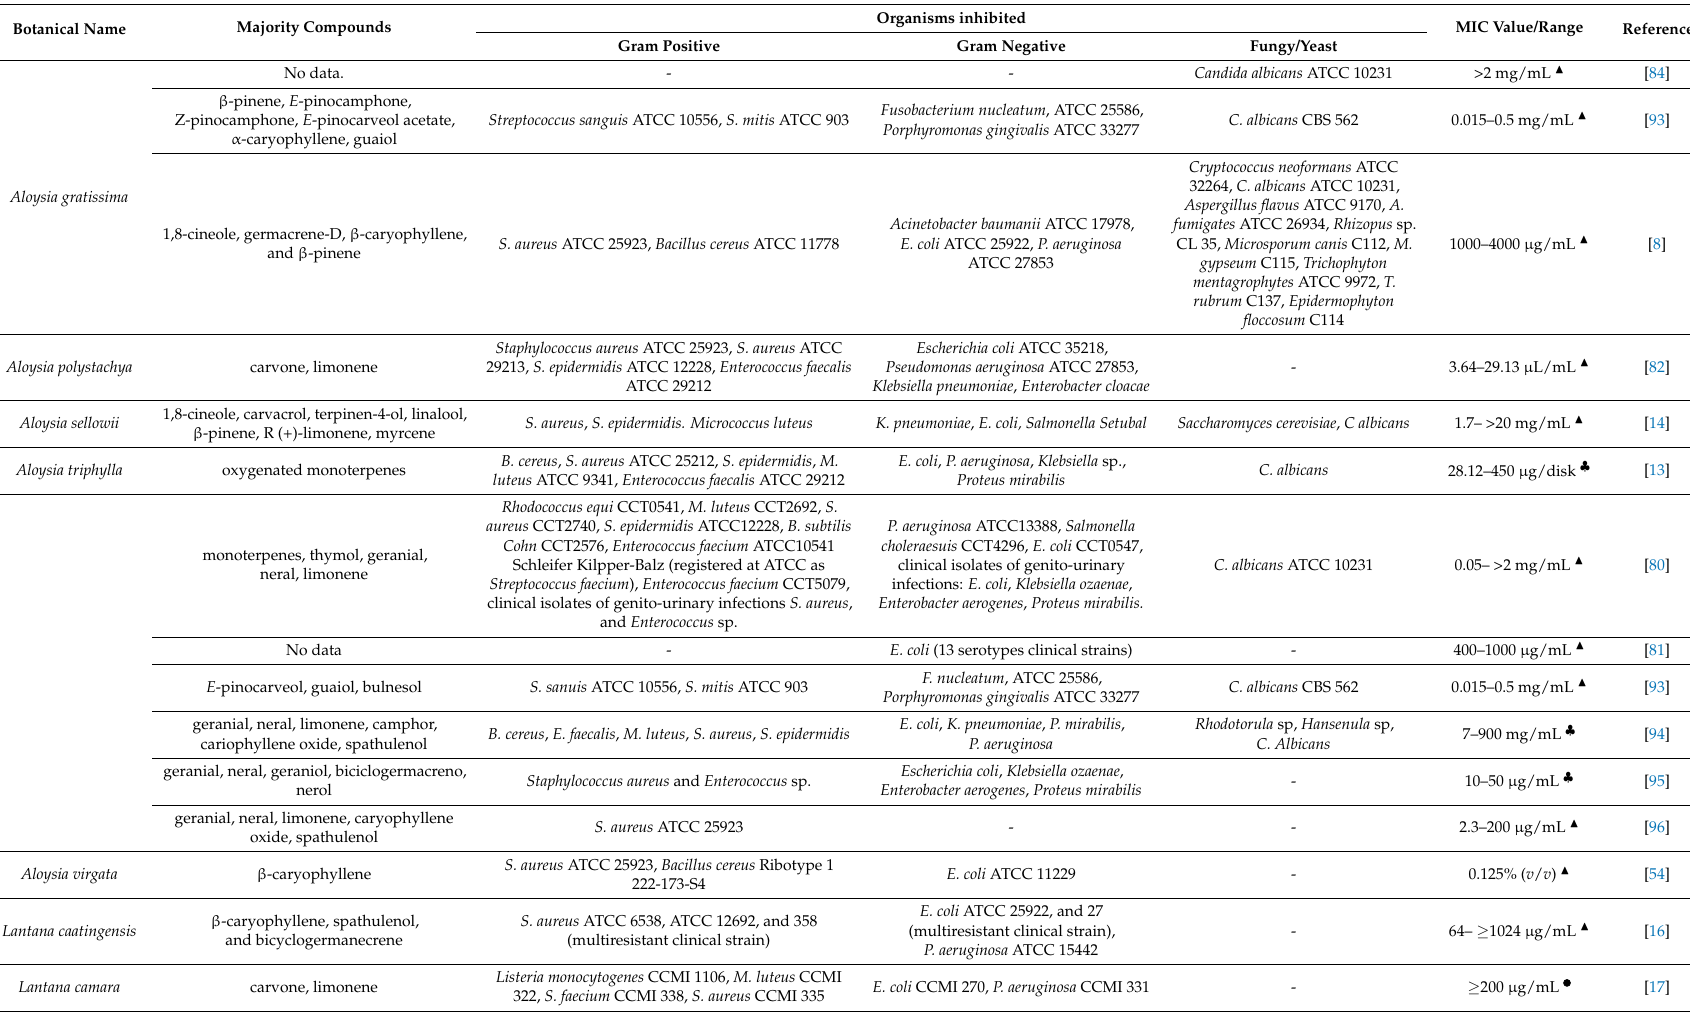
Table 2. Antimicrobial activity of essential oils (EOs) of plants belonging to the Verbenacea family against human pathogens (bacteria, fungi, or